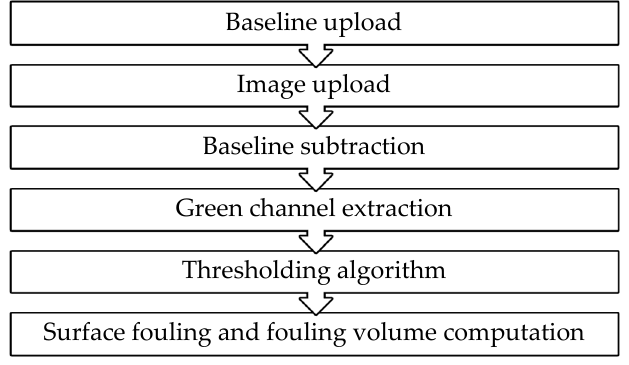
Figure 7. Image processing procedure.